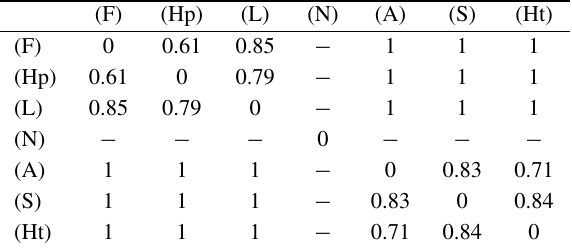
Table 9 Distance between the different sentiments as measured with D U .